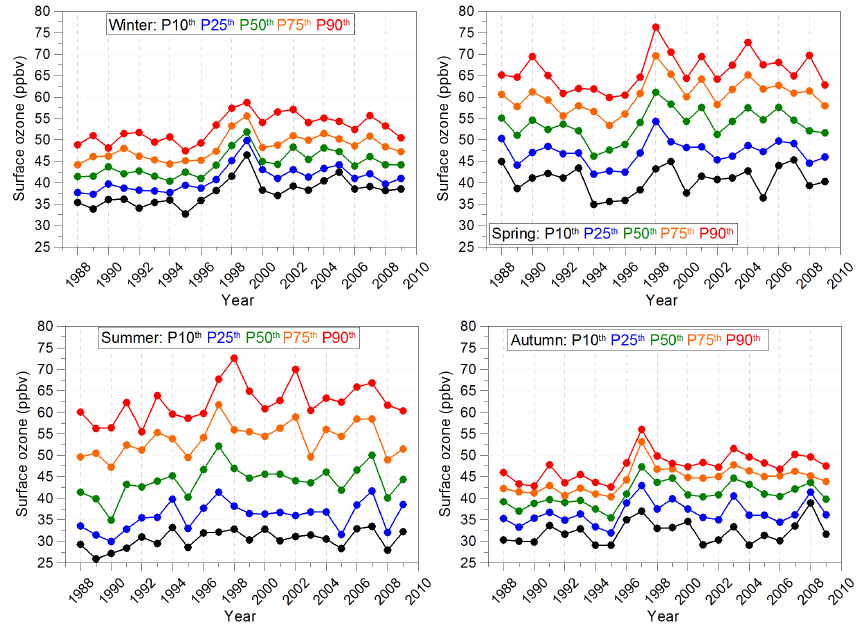
Fig. 3. Long-term (1988–2009) surface O 3 concentrations (night values: 22:00–06:00UTC) for percentiles 10th, 25th, 50th, 75th, and 90th at IZO for winter (JFM), spring (AMJ), summer (JAS) and autumn (OND).